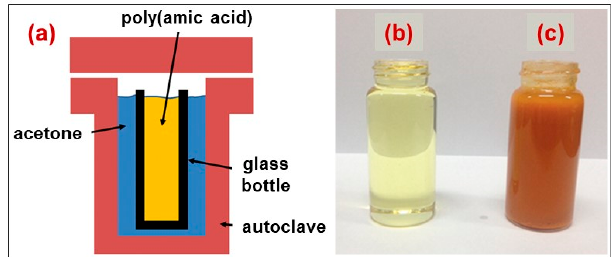
Figure 13. ( a ) Setup for the fabrication of PI aerogel microparticles. ( b ) Glass bottle with PAA before curing. ( c ) PI aerogel microparticles after curing. Copyright (2014) Wiley. Used with permission from Ref. [99].